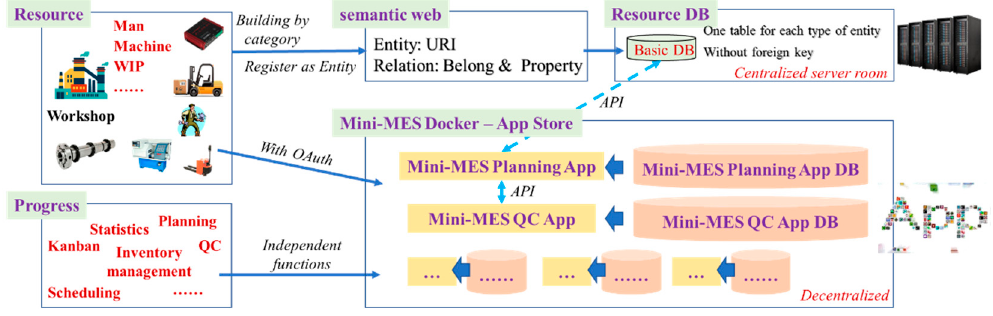
Figure 2. How the M 2 ES Apps System works.